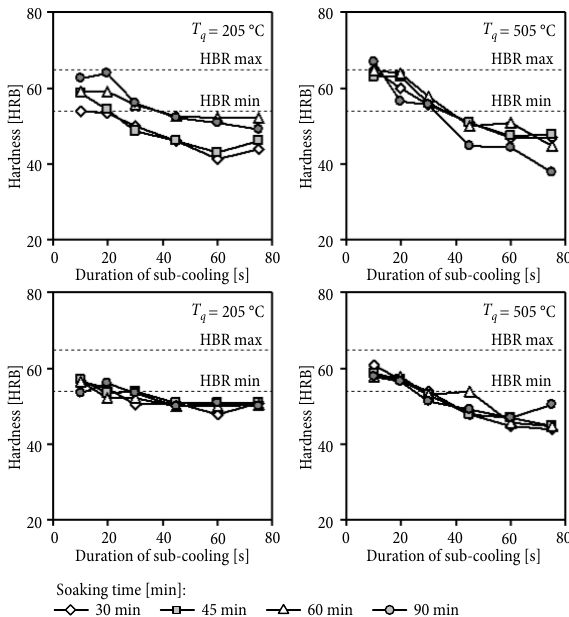
Fig. 9. A part of Regime C illustrating thermo-mechanical technology of connecting rods’: 1 – heating; 2 – soaking; 3 – sub-cooling; 4 – forging; 5 – water cooling (temperature ranges: I – interval of quenching; II – interval of plastic